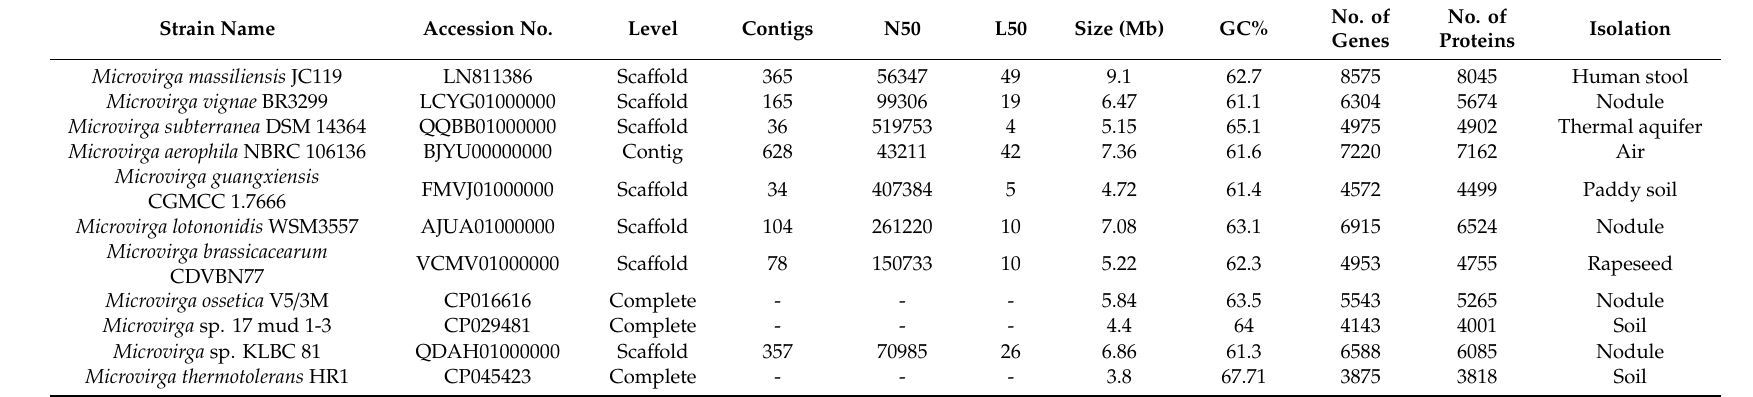
Table 3. General features of bacterial genomes used in this